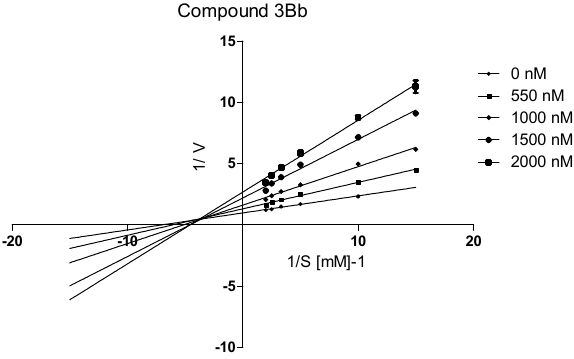
Figure 2. Lineweaver–Burk double reciprocal plot demonstrating mixed-type of h AChE inhibition by compound 3Bb . S = acetylthiocholine; V = initial velocity rate.